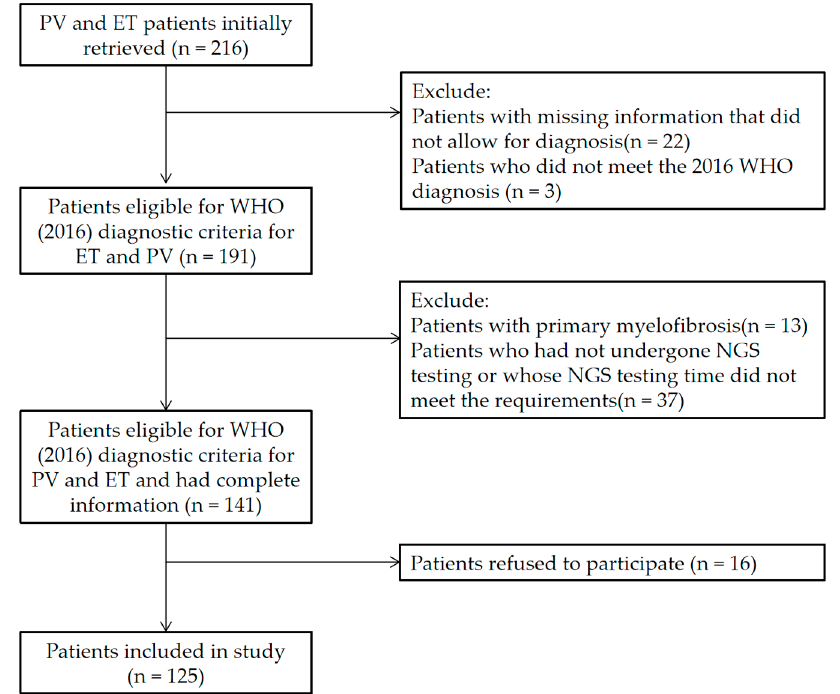
Figure 1. Patient selection flowchart.